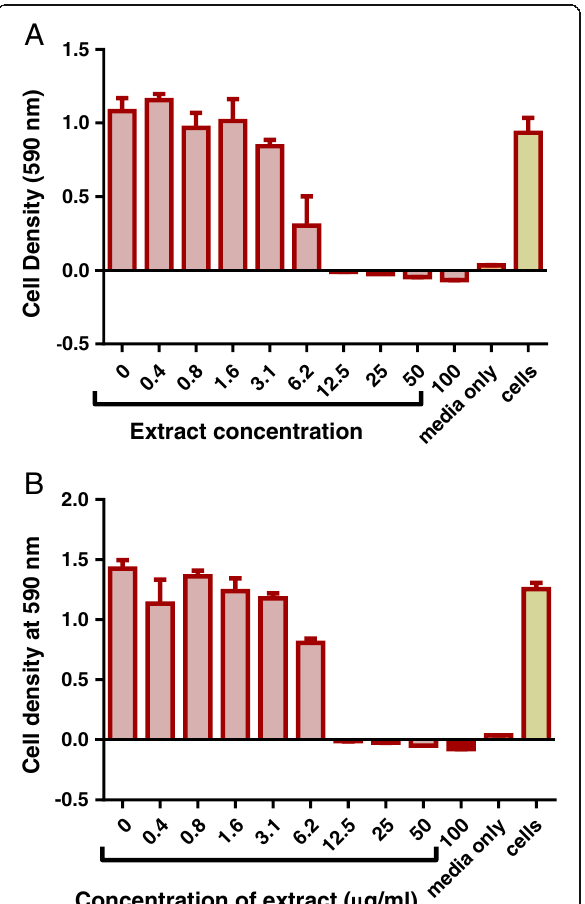
Fig. 1 The effect of standard antimycobacterial agents on the growth of M. smegmatis . M. smegmatis mc 2 155 was treated with different concentrations of isoniazid ( a ) and kanamycin ( b ) from 0 μ g/ml to 100 μ g/ml. The bacteria were incubated with drugs at 37 ̊ C for 20 h and cell density was determined by measuring absorbance of reduced MTT at 590 nm